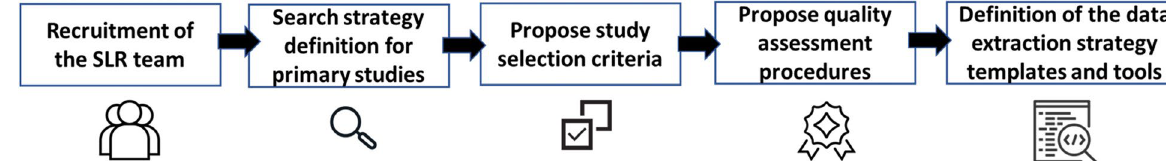
Fig. 4 Proposed literature review